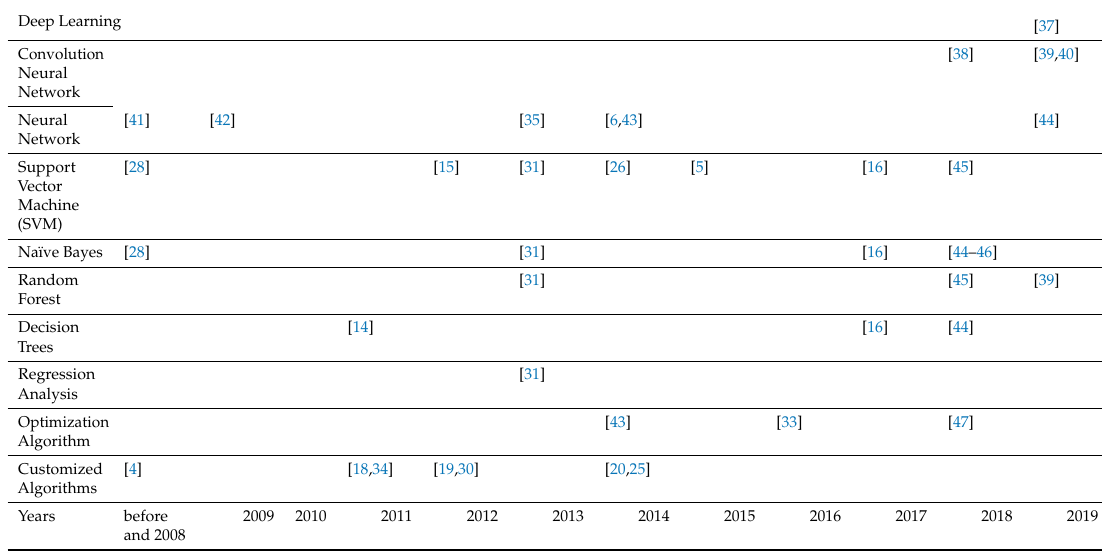
Table 1. Recently published medical research into the classification of diseases using machine-learning approaches. These studies have not used a structured coding scheme for data representation and, therefore, are unable to give any general framework for